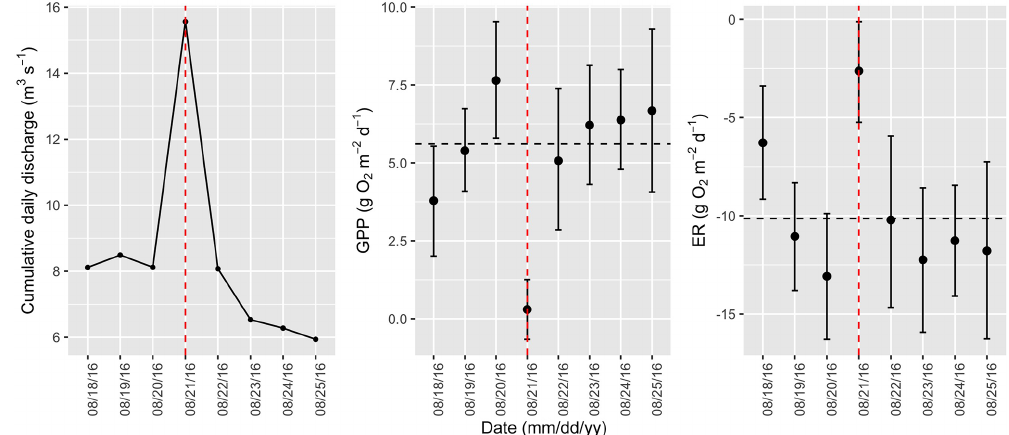
Figure A14. Cumulative daily discharge and metabolism (gross primary production and ecosystem respiration; GPP and ER) time series for the Stroubles Creek flow event on 21 August 2016 (noted with a dashed vertical red line in all three panels). The dashed horizontal black lines are mean values of GPP and ER prior to the high flow event. Error bars for posterior estimates of GPP and ER are 2.5% and 97.5% Bayesian credible intervals.